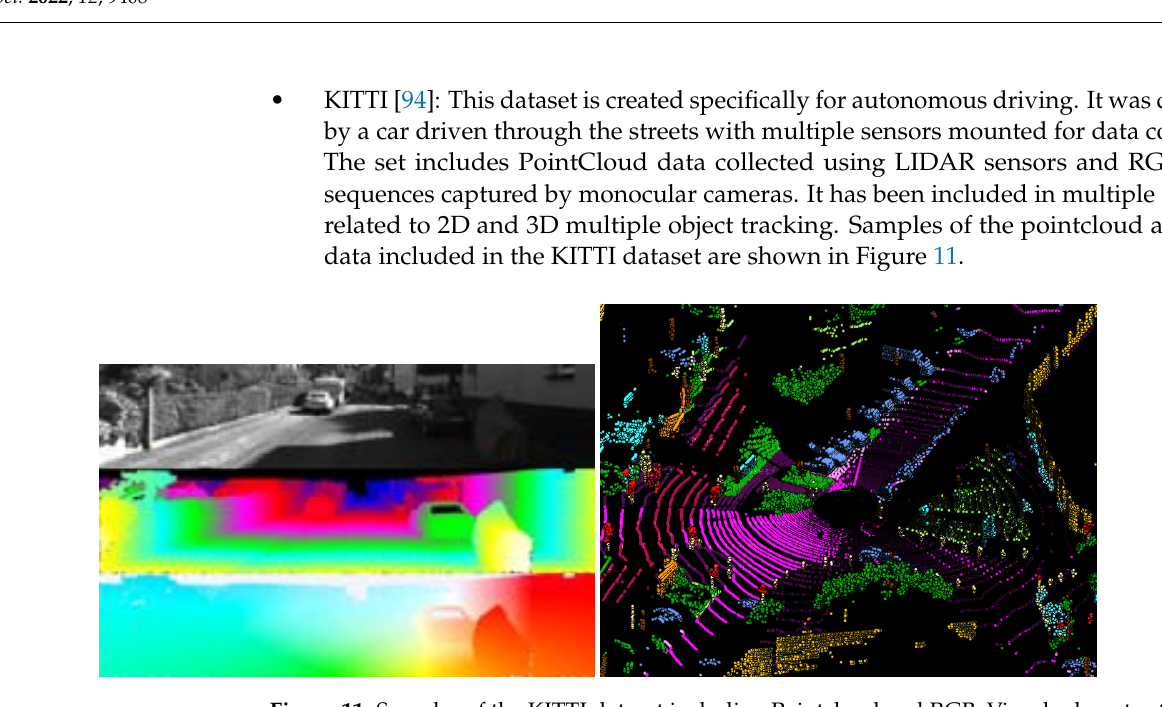
Figure 11. Samples of the KITTI dataset including Pointcloud and RGB. Visual odometry trajectory ( top left ), disparity and optical flow map ( top right ), visualized point cloud data [95] ( middle ), and 3D labels ( bottom ).